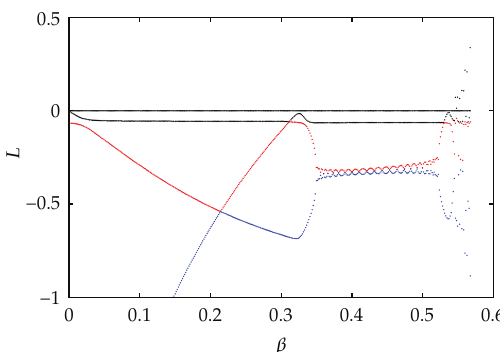
Figure 7: Lyapunov exponent with α (cid:7) − 0 . 1, β ∈ (cid:5) 0 , 0 . 6 (cid:6)